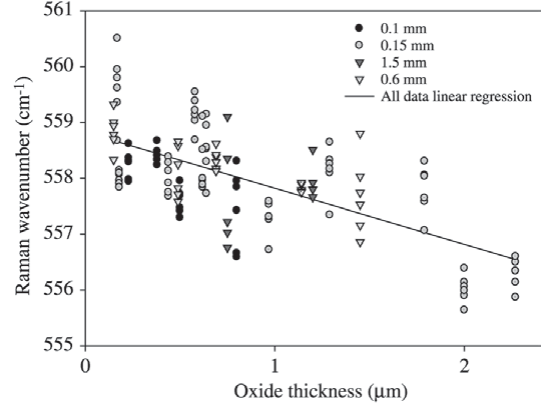
Figure 5. Room temperature Raman wavenumber as a function of oxide thickness for oxides isothermally grown on Fe-18Cr-TiNb specimens of different thickness.